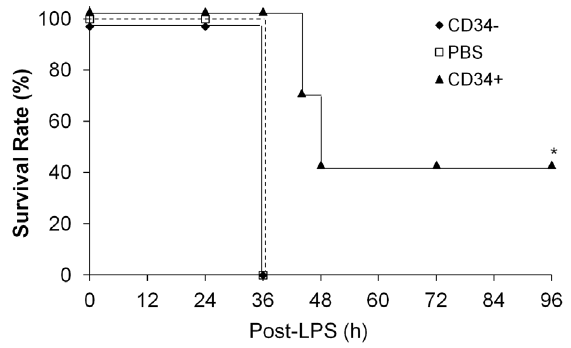
Figure 5. Increased survival of fCB-CD34 + cell-treated mice. After lethal dose of LPS challenge (11 mg/kg, i.p.), mice were monitored for 7 days to determine the survival rate ( n =7 per group). *, P , 0.01 versus PBS or CD34 2